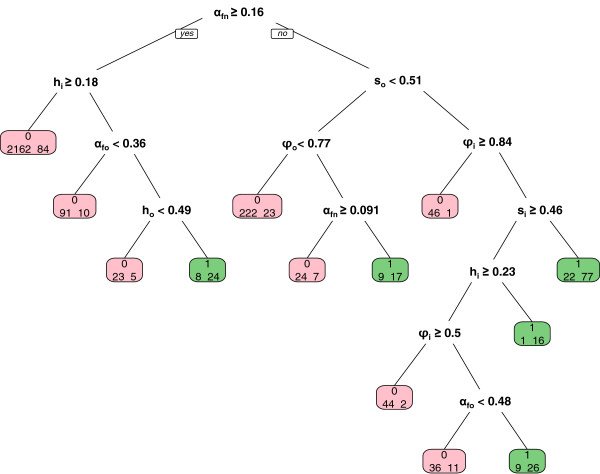
An example of a classification tree of outcomes y > 1 (class 1) and y < 1 (class 0) using all the parameters in the model except k. The items displayed in the nodes in the tree diagram are: the criterion for making the decision (e.g.: αfn ≥ 0.1626), the predicted class for that terminal node (0 or 1) and the number of observations correctly classified to the class versus the number misclassified, achieved by cross-validation (e.g.: 2162/84). To proceed through the diagram at a given node move to the left branch if the stated condition is true (yes) and to the right if false (no).